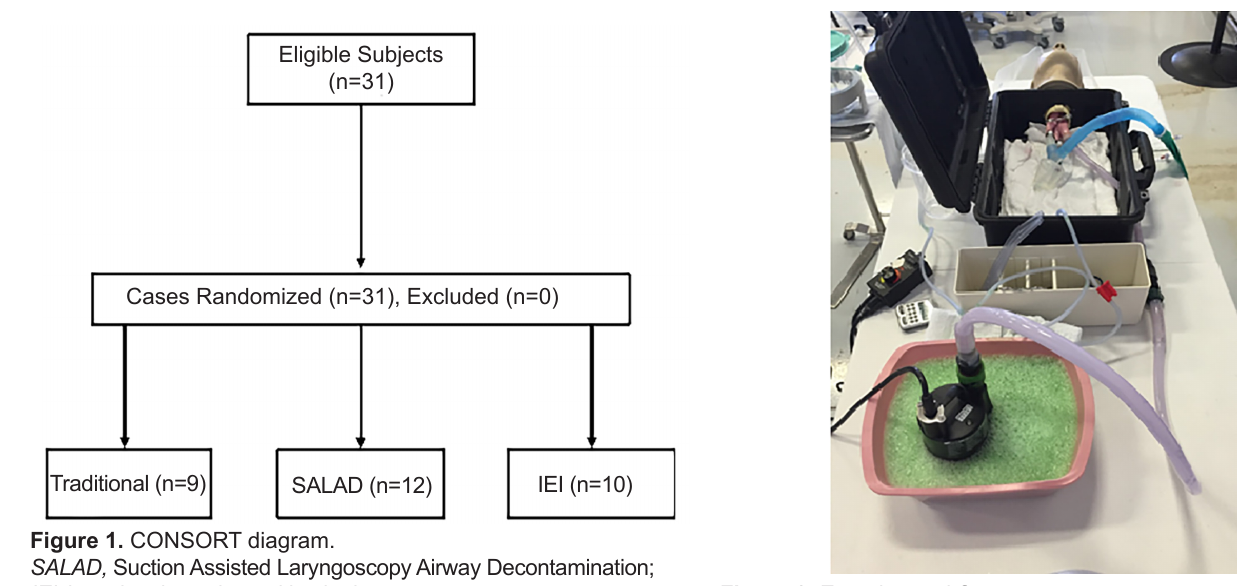
Figure 2. Experimental